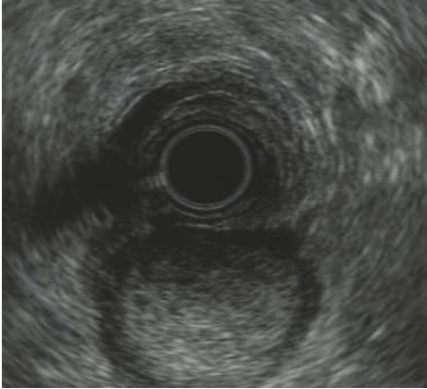
Figure 2: Ultrasound image of glomus tumor.